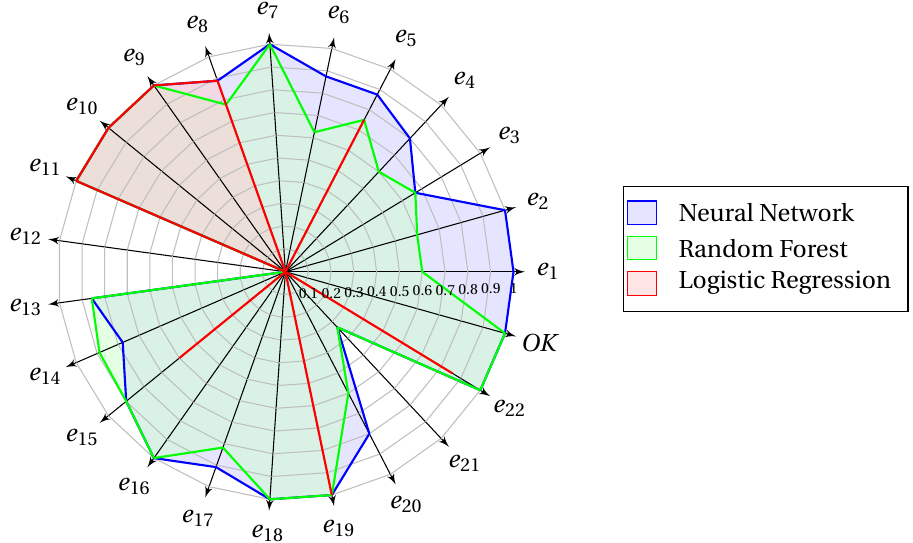
Figure 12. Comparison of the results of 3 applied methods machine learning in terms of recall.